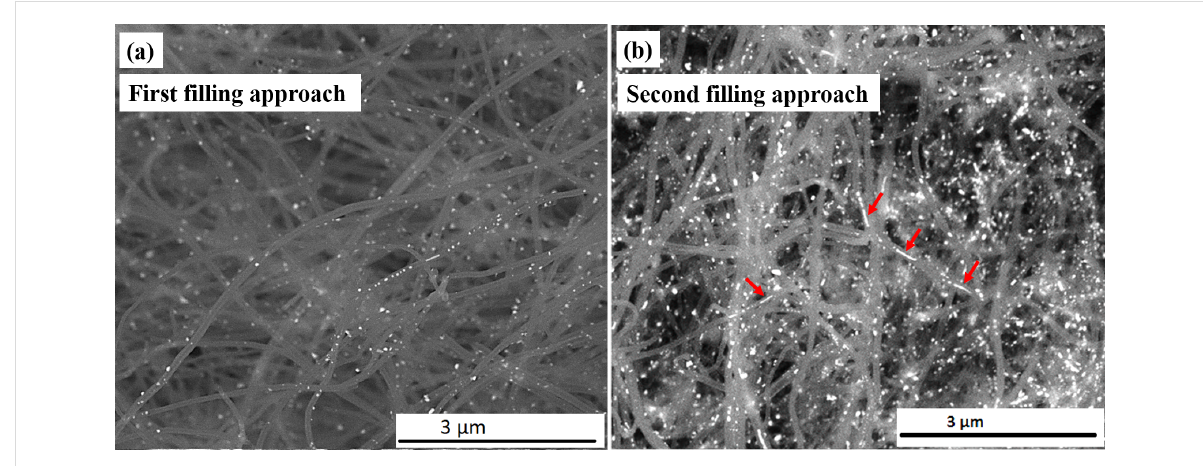
Figure 1: SEM overview images in back scattering electron (BSE) contrast mode for the as-prepared samples of Fe 50 Co 50 @CNT prepared by the a) first (solution) and b) second filling approach.